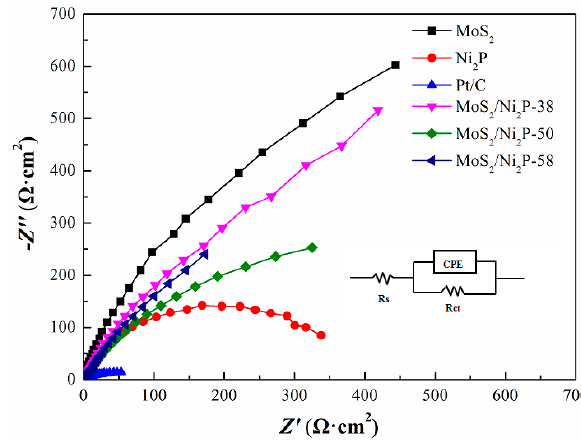
Figure 8. EIS spectra of pure MoS 2 , Ni 2 P, three MoS 2 /Ni 2 P hybrids, and commercial 20 wt % Pt/C. Cathodic overpotential: 0.7 V, frequency: 10 5 Hz–0.01 Hz, amplitude of the sinusoidal signal: 5 mV. Table 3. Parameters of solution resistance ( R s ), charge transfer resistance ( R ct ), double-layer capacitance ( C dl ), the dimensionless CPE exponent n , and exchange current density ( j 0 ) analyzed from the EIS